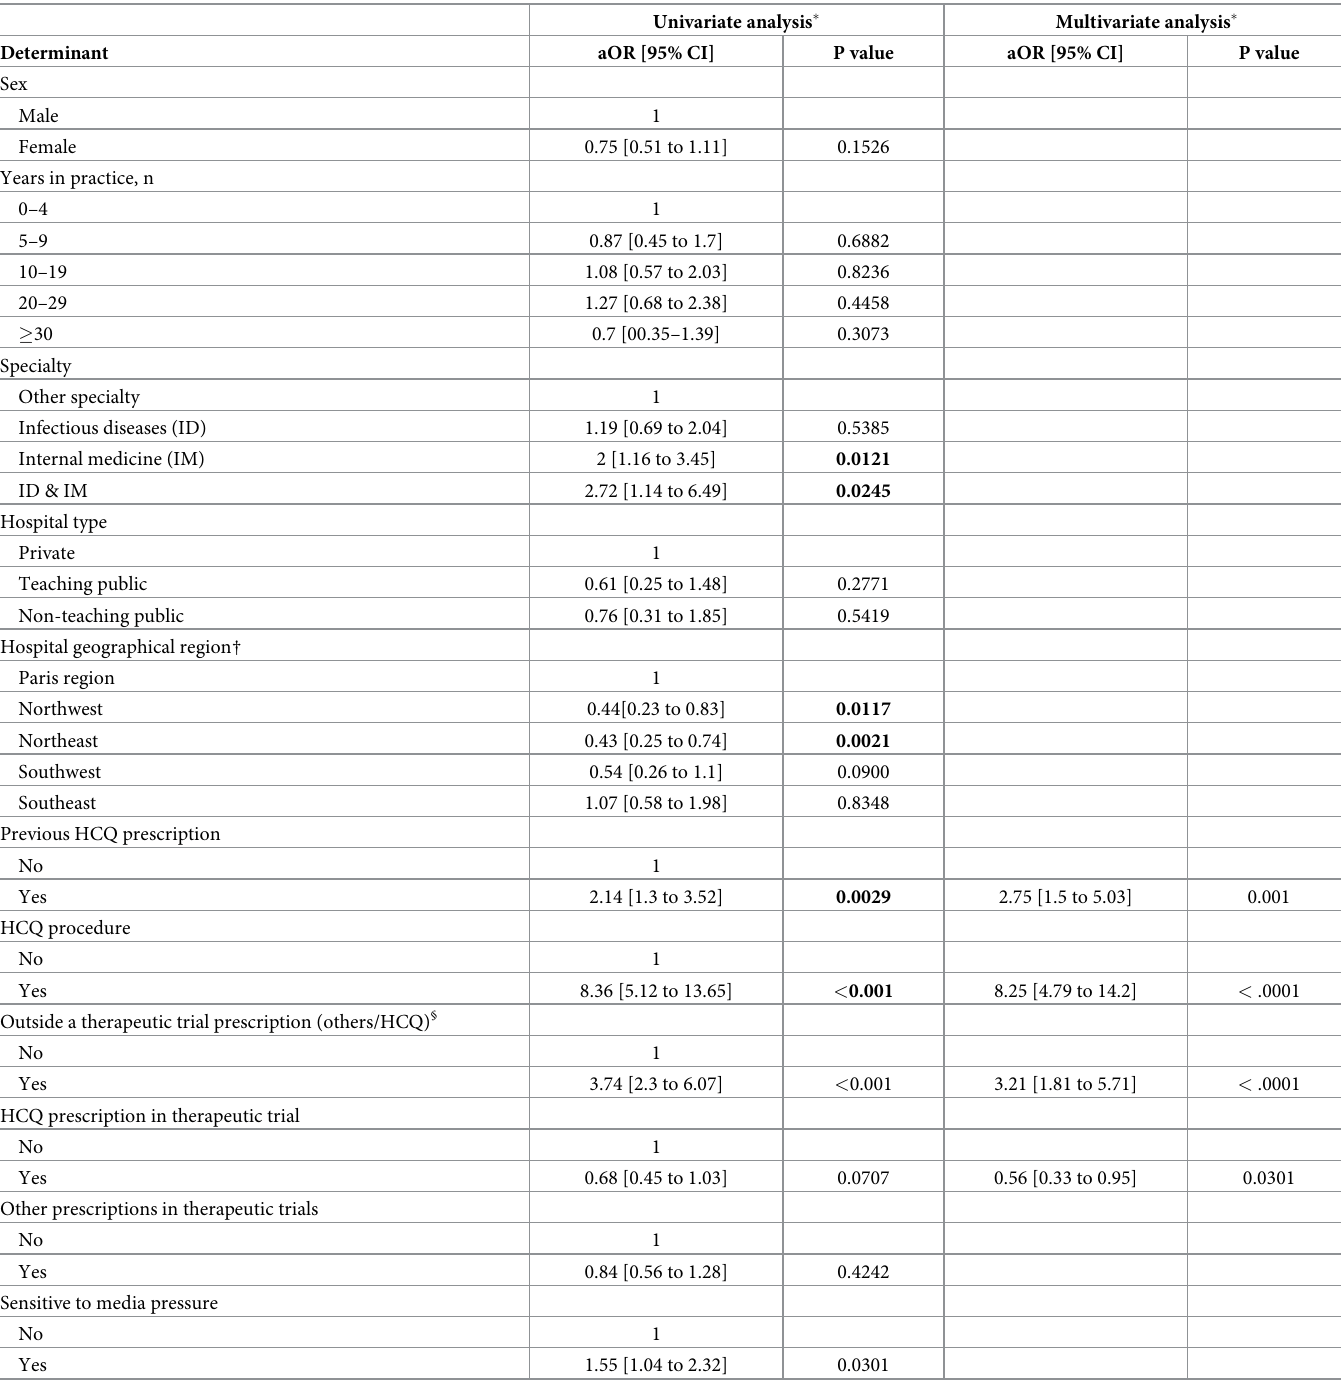
Table 3. Univariate and multivariate analyses of HCQ-prescription